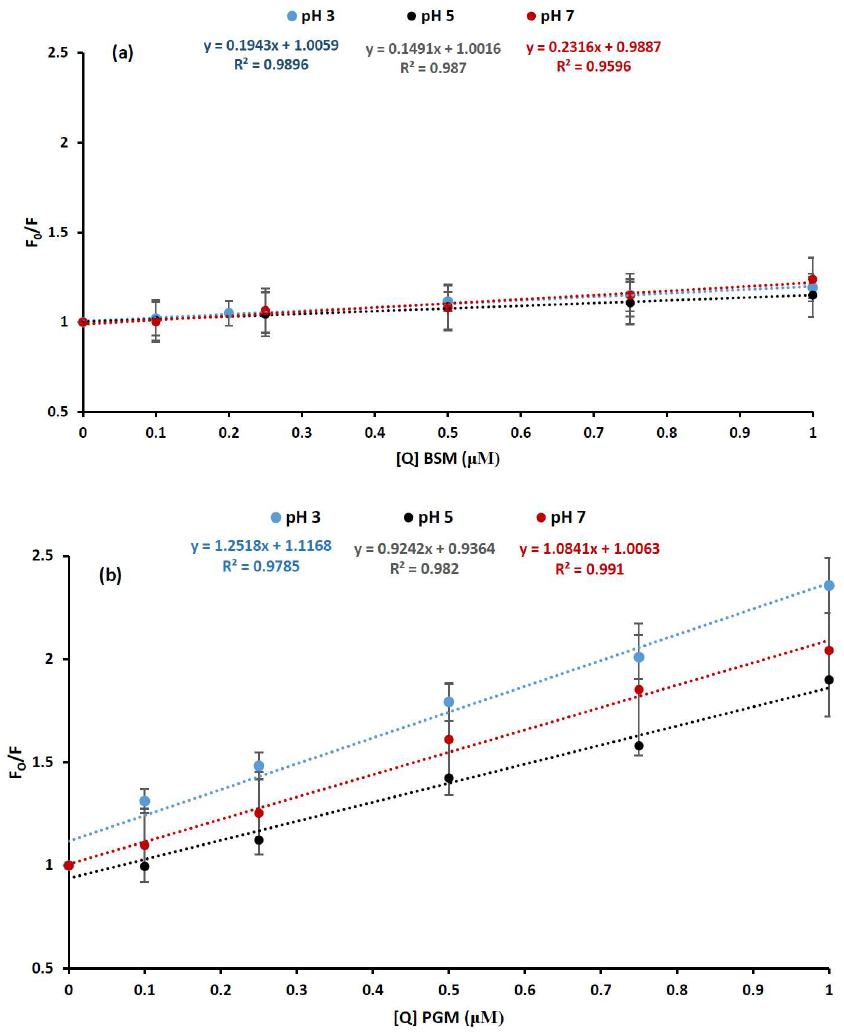
Figure 4. A linear Stern–Volmer relationship describing tryptophan quenching of β-Lactoglobulin (28 μM) at low quencher (mucin) concentrations (≤ 1 μM) in different pH values of phosphate buffer solutions (blue: pH = 3, black: pH = 5, red: pH = 7): ( a ) bovine submaxillary mucin (BSM) and ( b ) porcine gastric mucin (PGM). The fluorescence emission intensity was recorded at λ ex 280 nm and the λ em maximum occurred at 326 nm.